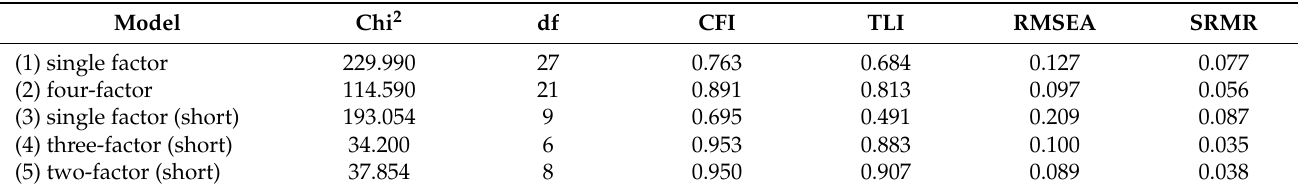
Table 3. Results of Confirmatory Factor Analysis examining the factorial structure of the Health Consciousness Scale— German (HCS-G).